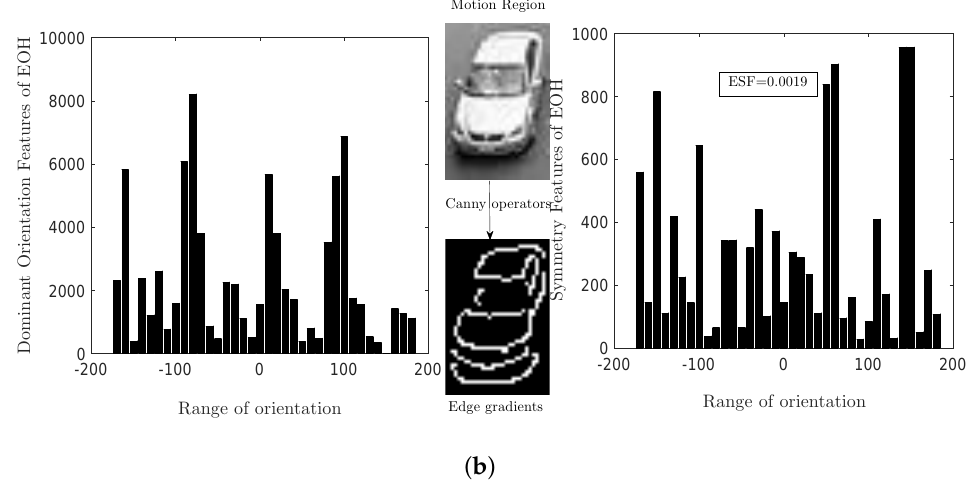
Figure 3. Histogram of Edge Orientation: Left figure of ( a , b ): Dominant Orientation Features. Right figure of ( a , b ): Symmetry Features.